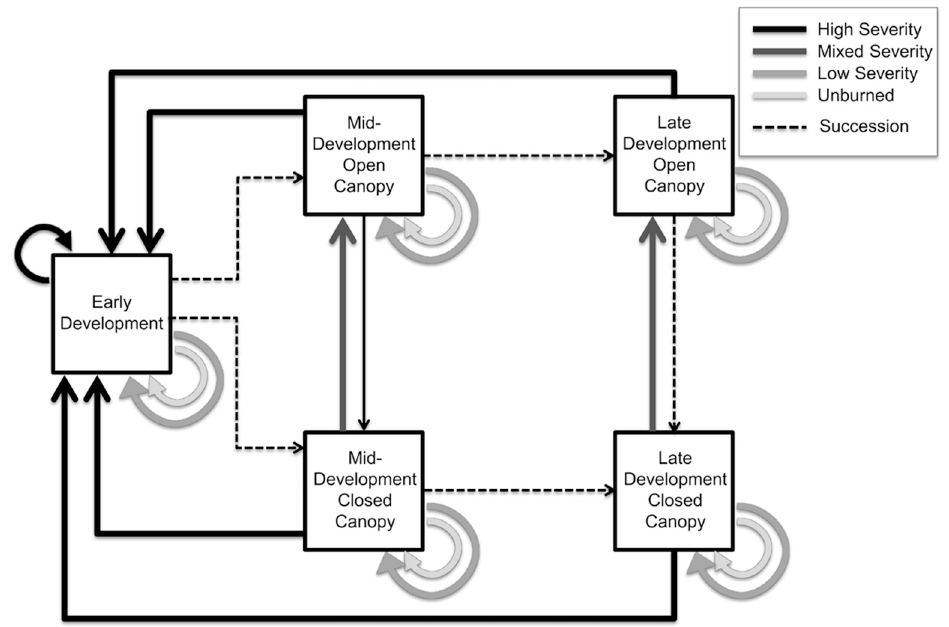
Figure 3. State-and-transition model of the Vegetation Dynamics Development Tool successional states and ecological transitions as affected by differential wildfire severity (modified from [4]). Table 4. Quantitative criteria and thresholds utilized to classify plots into the five successional states that describe the forest structure for the three Biophysical Setting (BpS) models present in the study area. Both the initial classification of the plots into BpS models and further classification into successional states also utilized qualitative information and species lists in the BpS model descriptions, which can be found on the LANDFIRE website (www.landfire.gov).